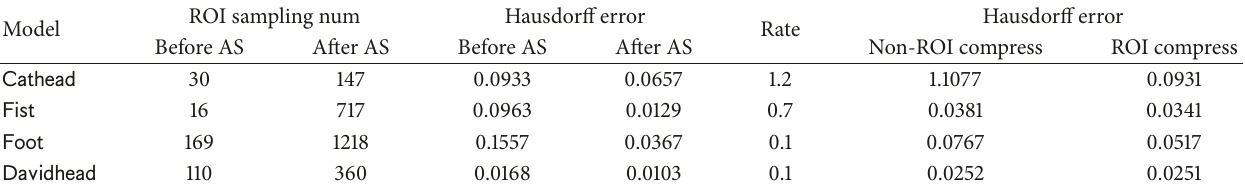
Table 2: Hausdorff error of different models using ROI sampling